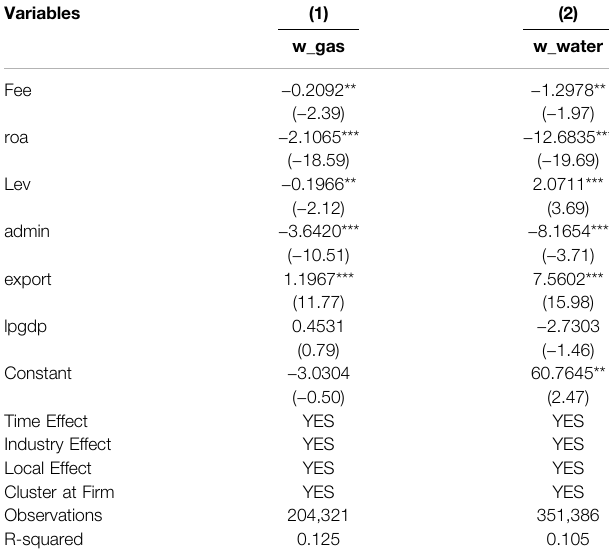
TABLE 3 | Full sample regression